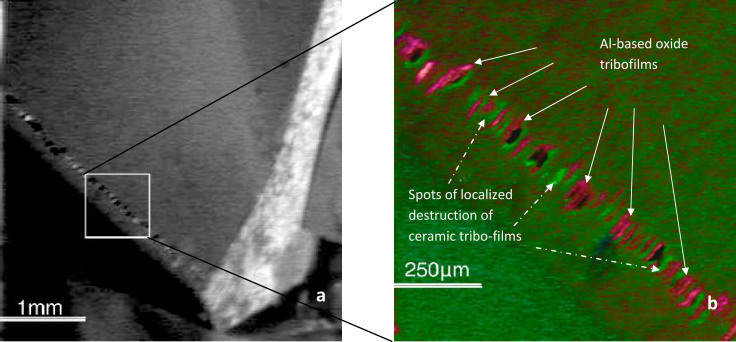
Auger image of atomic scale tribo-films forming on worn surface (a) – general image of in O KLL512 (topography contrast); (b) – red image in O KLL508.5; light green image in N KLL377.5.